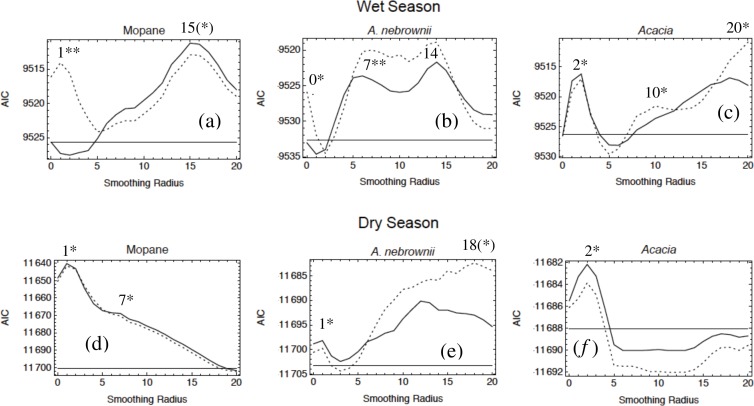
Habitat selection by female elephants in Etosha for the variables mopane, A. nebrownii, and Acacia in both the wet and dry seasons.(A–C) During the wet season, when water is not limiting, individuals utilize more of the landscape and select habitat variables at larger scales more strongly than in the dry season. (D–F) During the dry season, when individuals are more restricted in their movements to areas near water, habitat variables are typically selected more strongly at a smaller scale than at a larger scale. Each variable is fit to three models: distance from current location only (straight solid line), distance and the linear habitat variable (jagged solid line), and distance with both the linear and quadratic values (dashed line). Each of the peaks of model fit is indicated. A single asterisk indicates that only the linear value was chosen, and a double asterisk indicates that both the linear and quadratic values were chosen. An asterisk in parentheses indicates that the variable was not included in the best overall model.